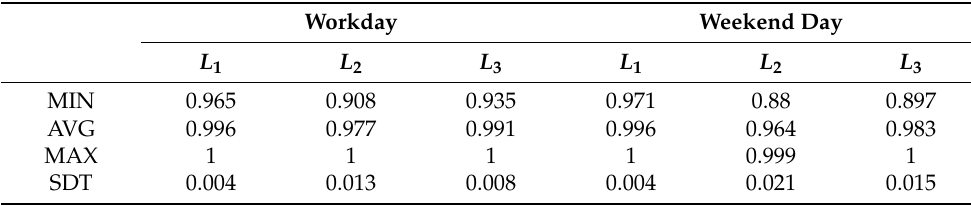
Table 7. The main values of displacement power factors (DPF) (-).